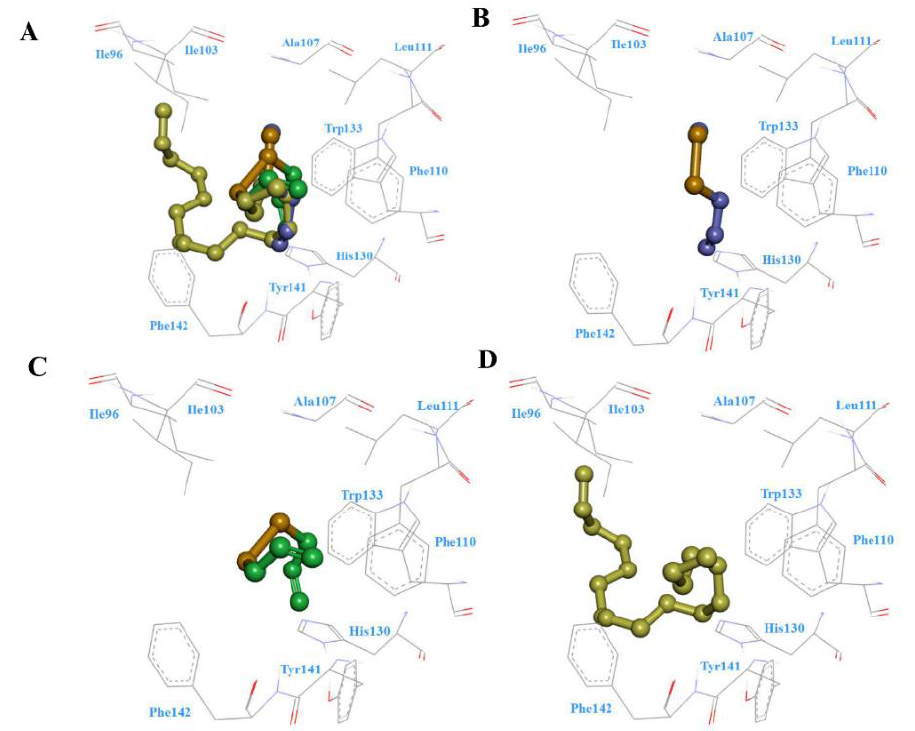
Figure 5. The docking mode between diallyl disulfide (purple), methyl allyl disulfide (green), and